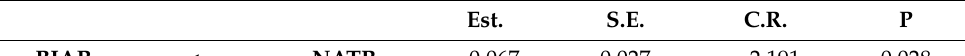
Table 6. SEM Regression Results. Est. S.E. C.R. P BIAR <— NATR − 0.067 0.027 − 2.191 0.028 BIAR <— THRC 0.953 0.101 11.544